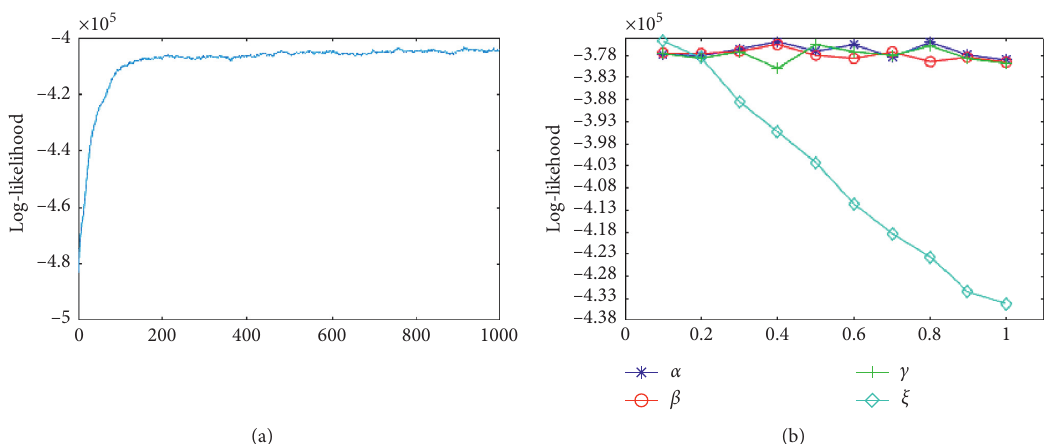
Figure 2: (a) Trend of the log-likelihood probability of Cora with iterations. (b) Trend of the log-likelihood probability of Cora with α , β , c , and ξ , respectively.